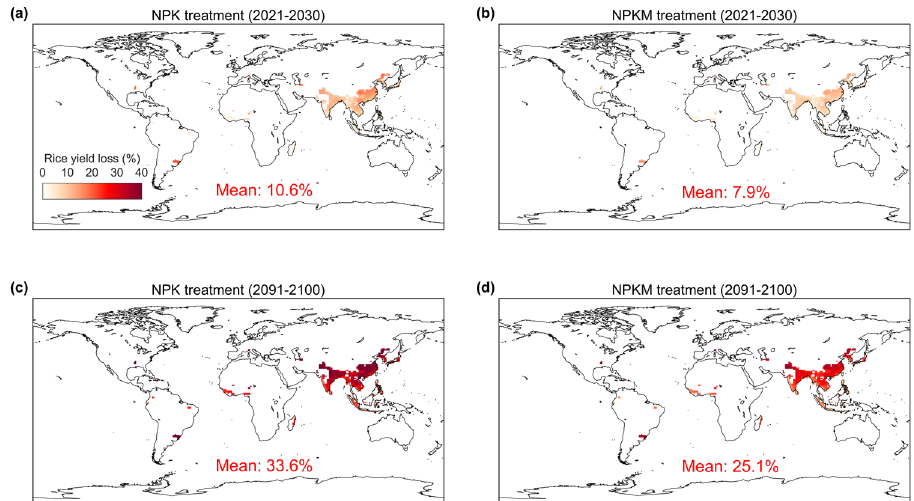
Fig. 5 Projected global losses of rice yield due to extreme temperatures. a Global losses of rice yield due to extreme temperatures under NPK in 2021 – 2030, b global losses of rice yield due to extreme temperatures under NPKM in 2021 – 2030, c global losses of rice yield due to extreme temperatures under NPK in 2091 – 2100, d global losses of rice yield due to extreme temperatures under NPKM in 2091 –